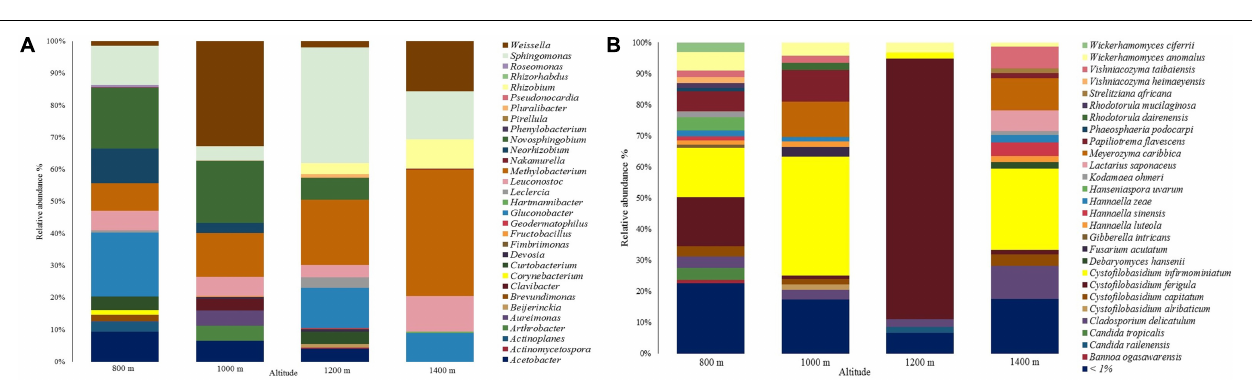
FIGURE 2 | Relative abundance of the microbial communities at different altitudes. (A) Bacterial community. (B) Fungal community.